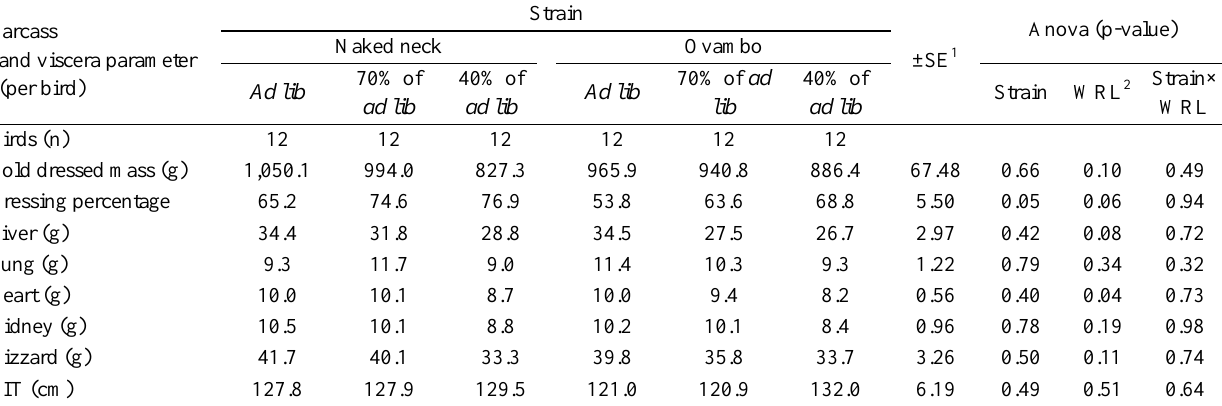
Table 4. Carcass and internal organ weights of 16 week old female Naked Neck and Ovambo chickens raised with or without water restriction Carcass and viscera parameter